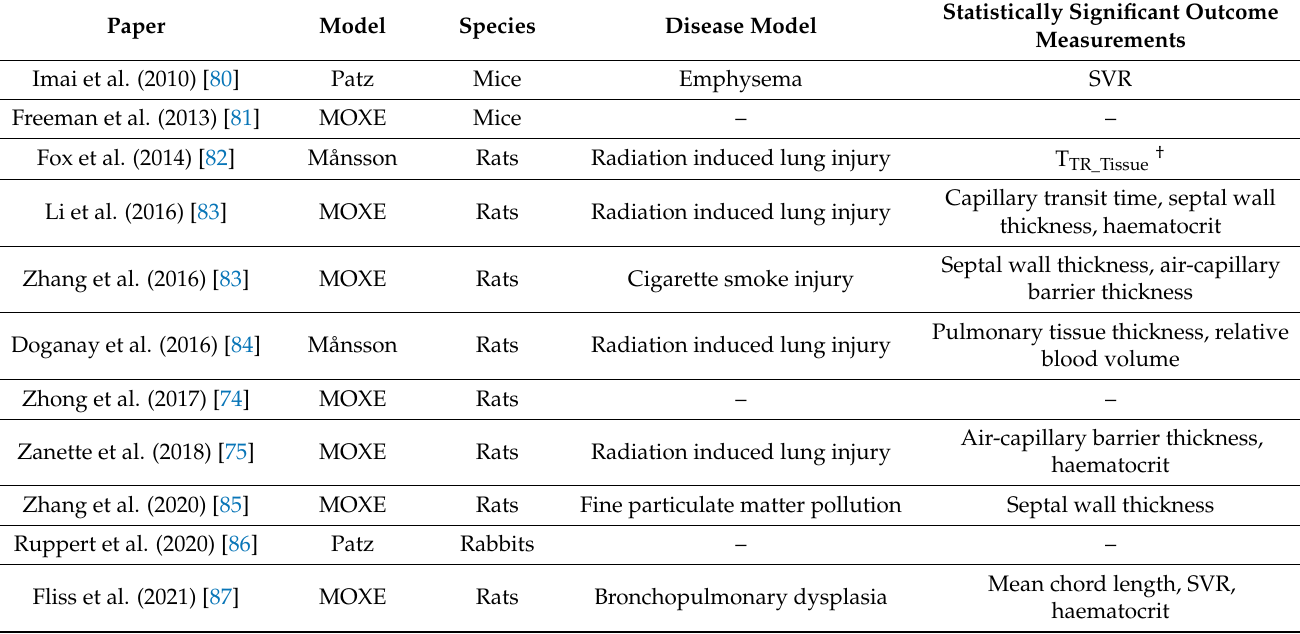
Table 1. A summary of gas exchange experiments performed in